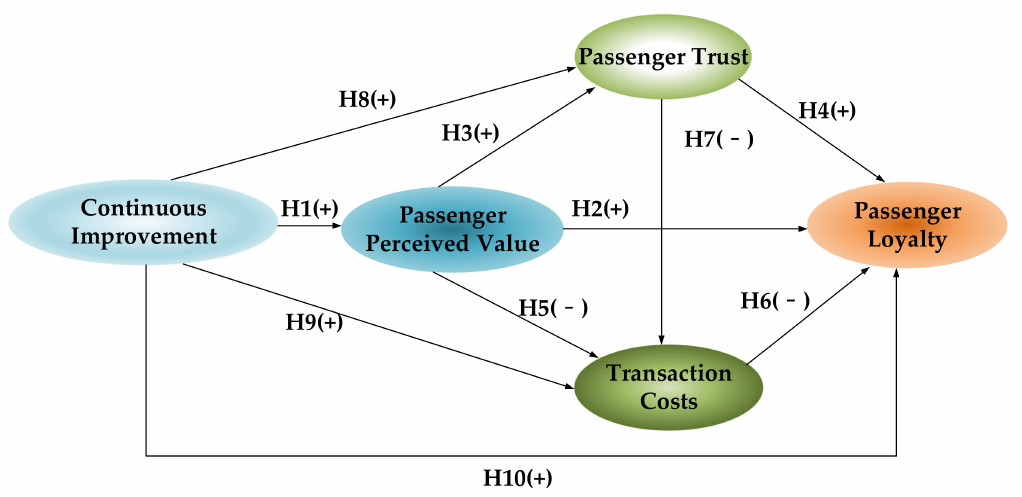
Figure 4. Alternative Model 1.